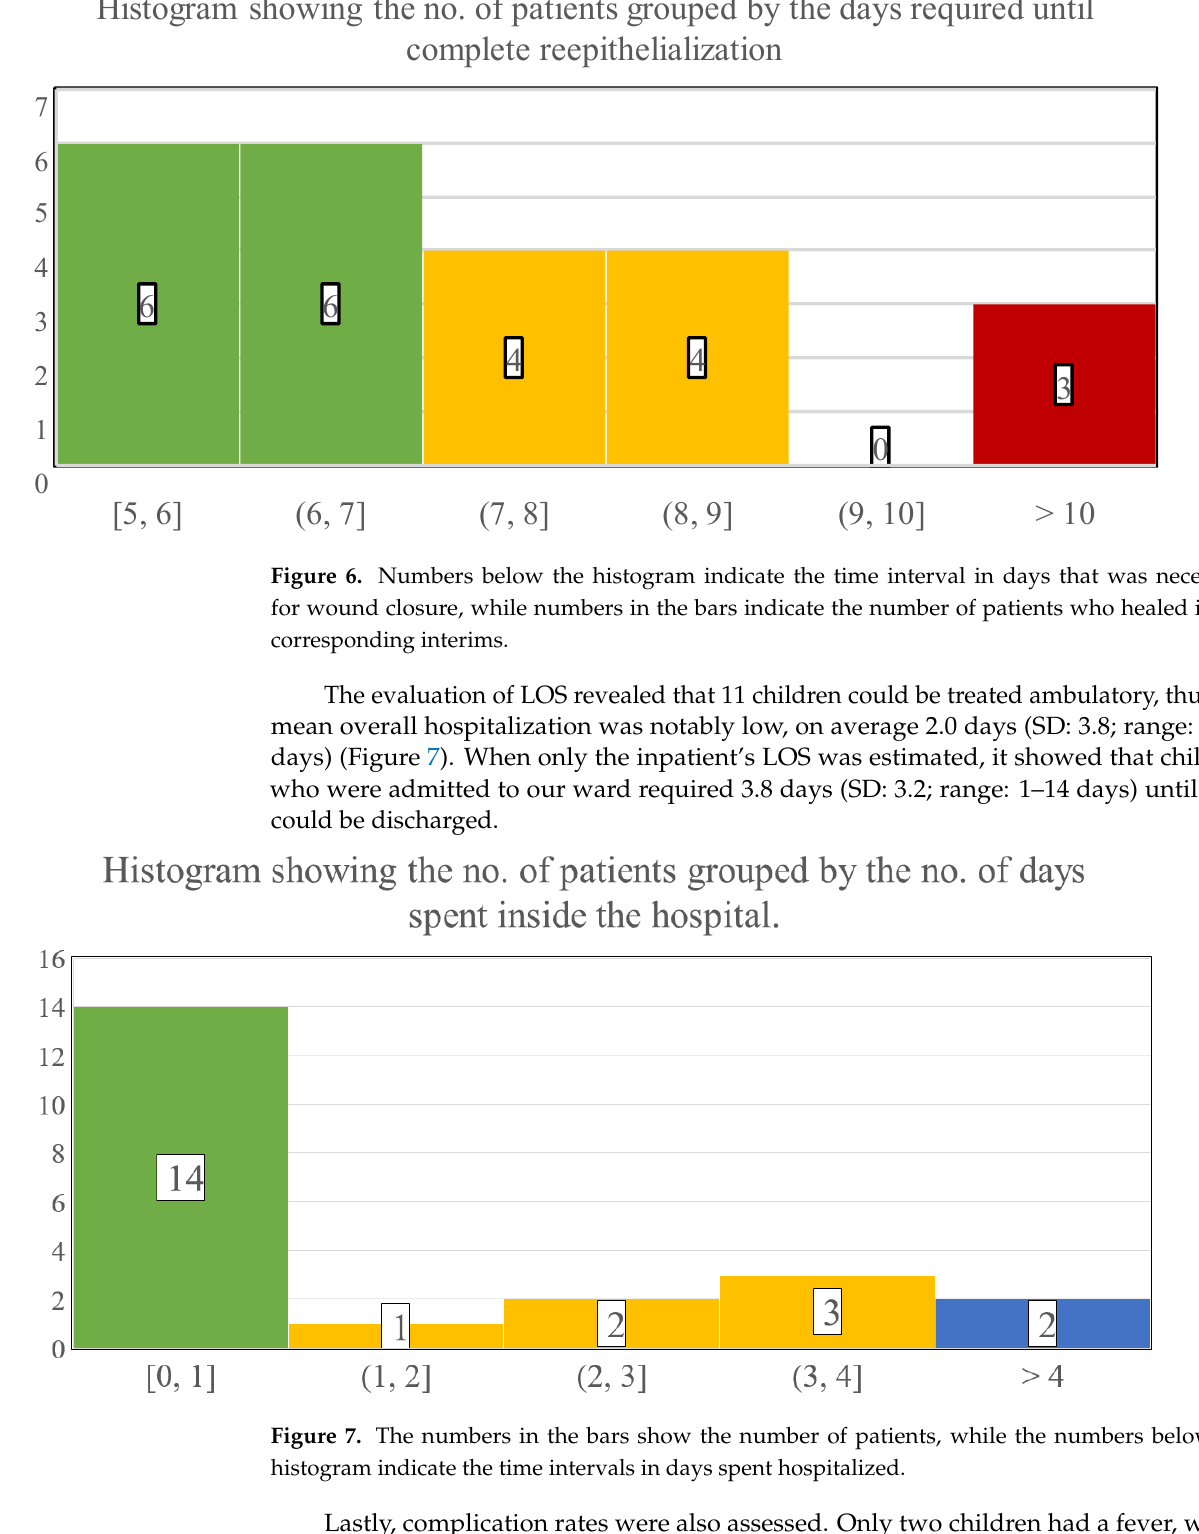
Figure 7. The numbers in the bars show the number of patients, while the numbers below the his- togram indicate the time intervals in days spent hospitalized.